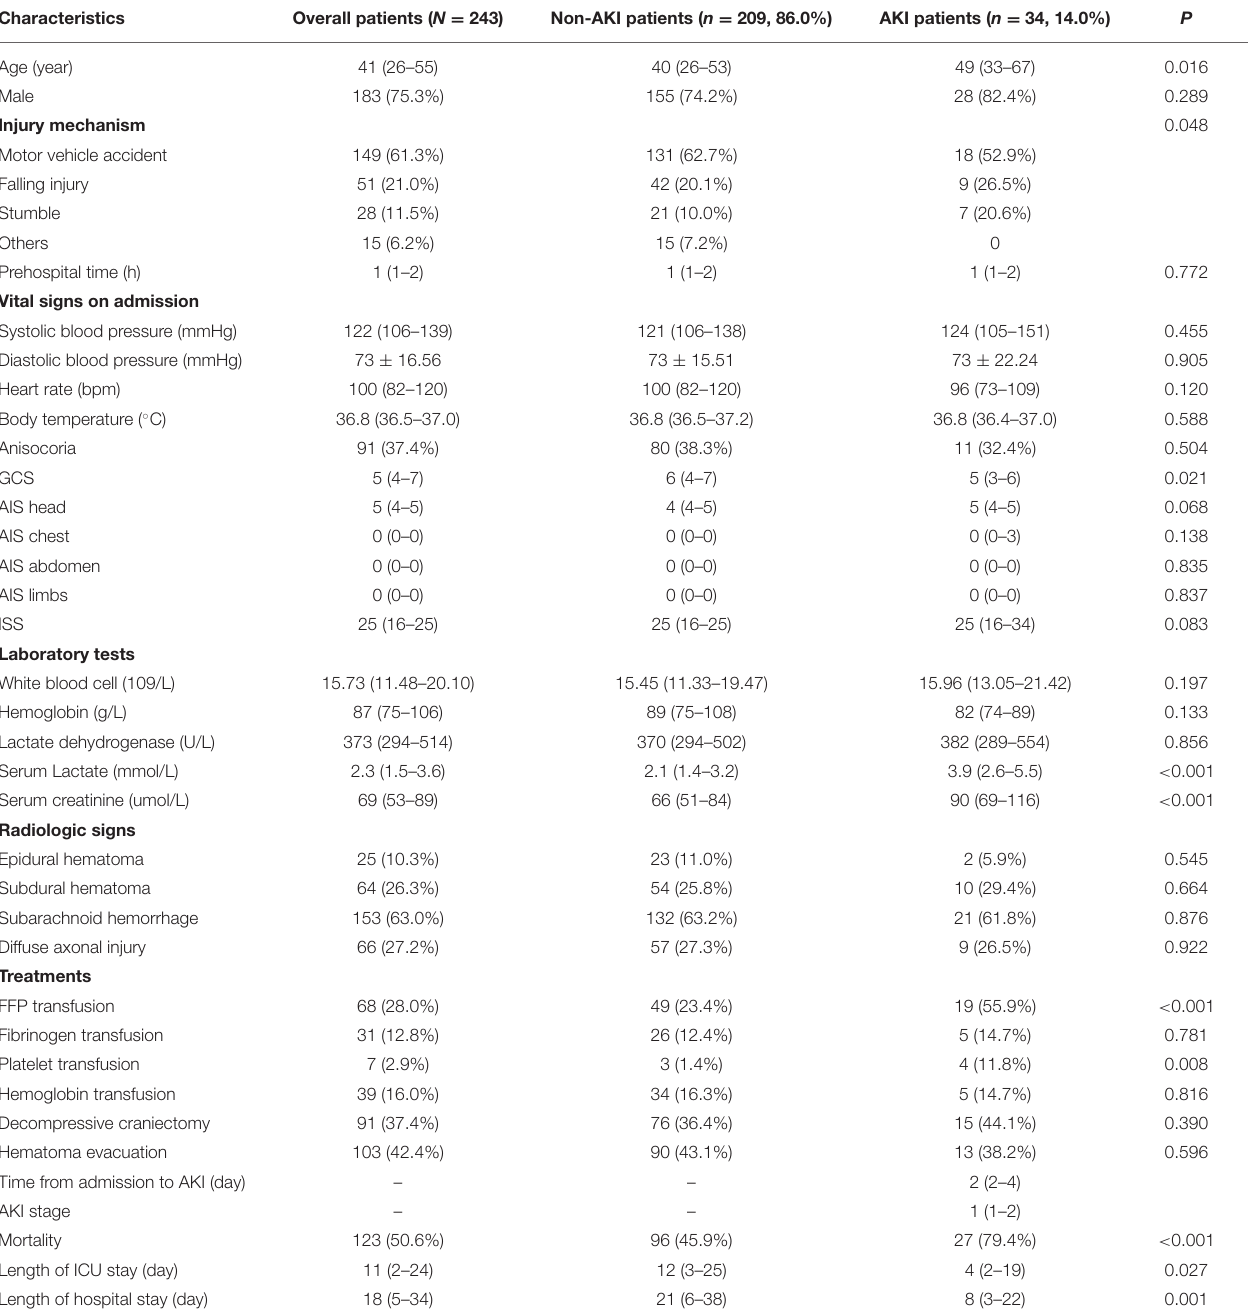
TABLE 1 | Baseline characteristics of included TBI patients with and without AKI.